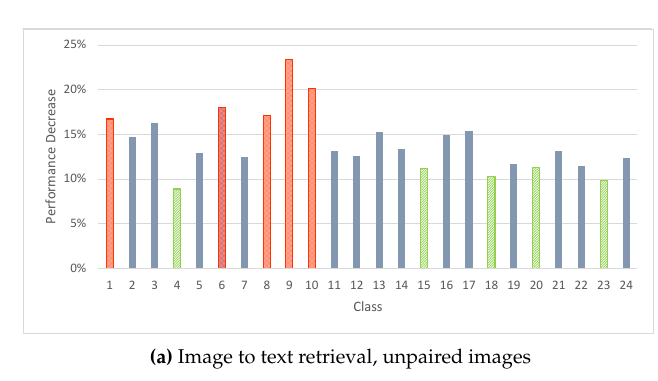
Table 9. MIR-Flickr25K class-by-class mAP@N evaluation using 64-Bit DADH. Fully paired, 80% unpaired images and 80% unpaired text.